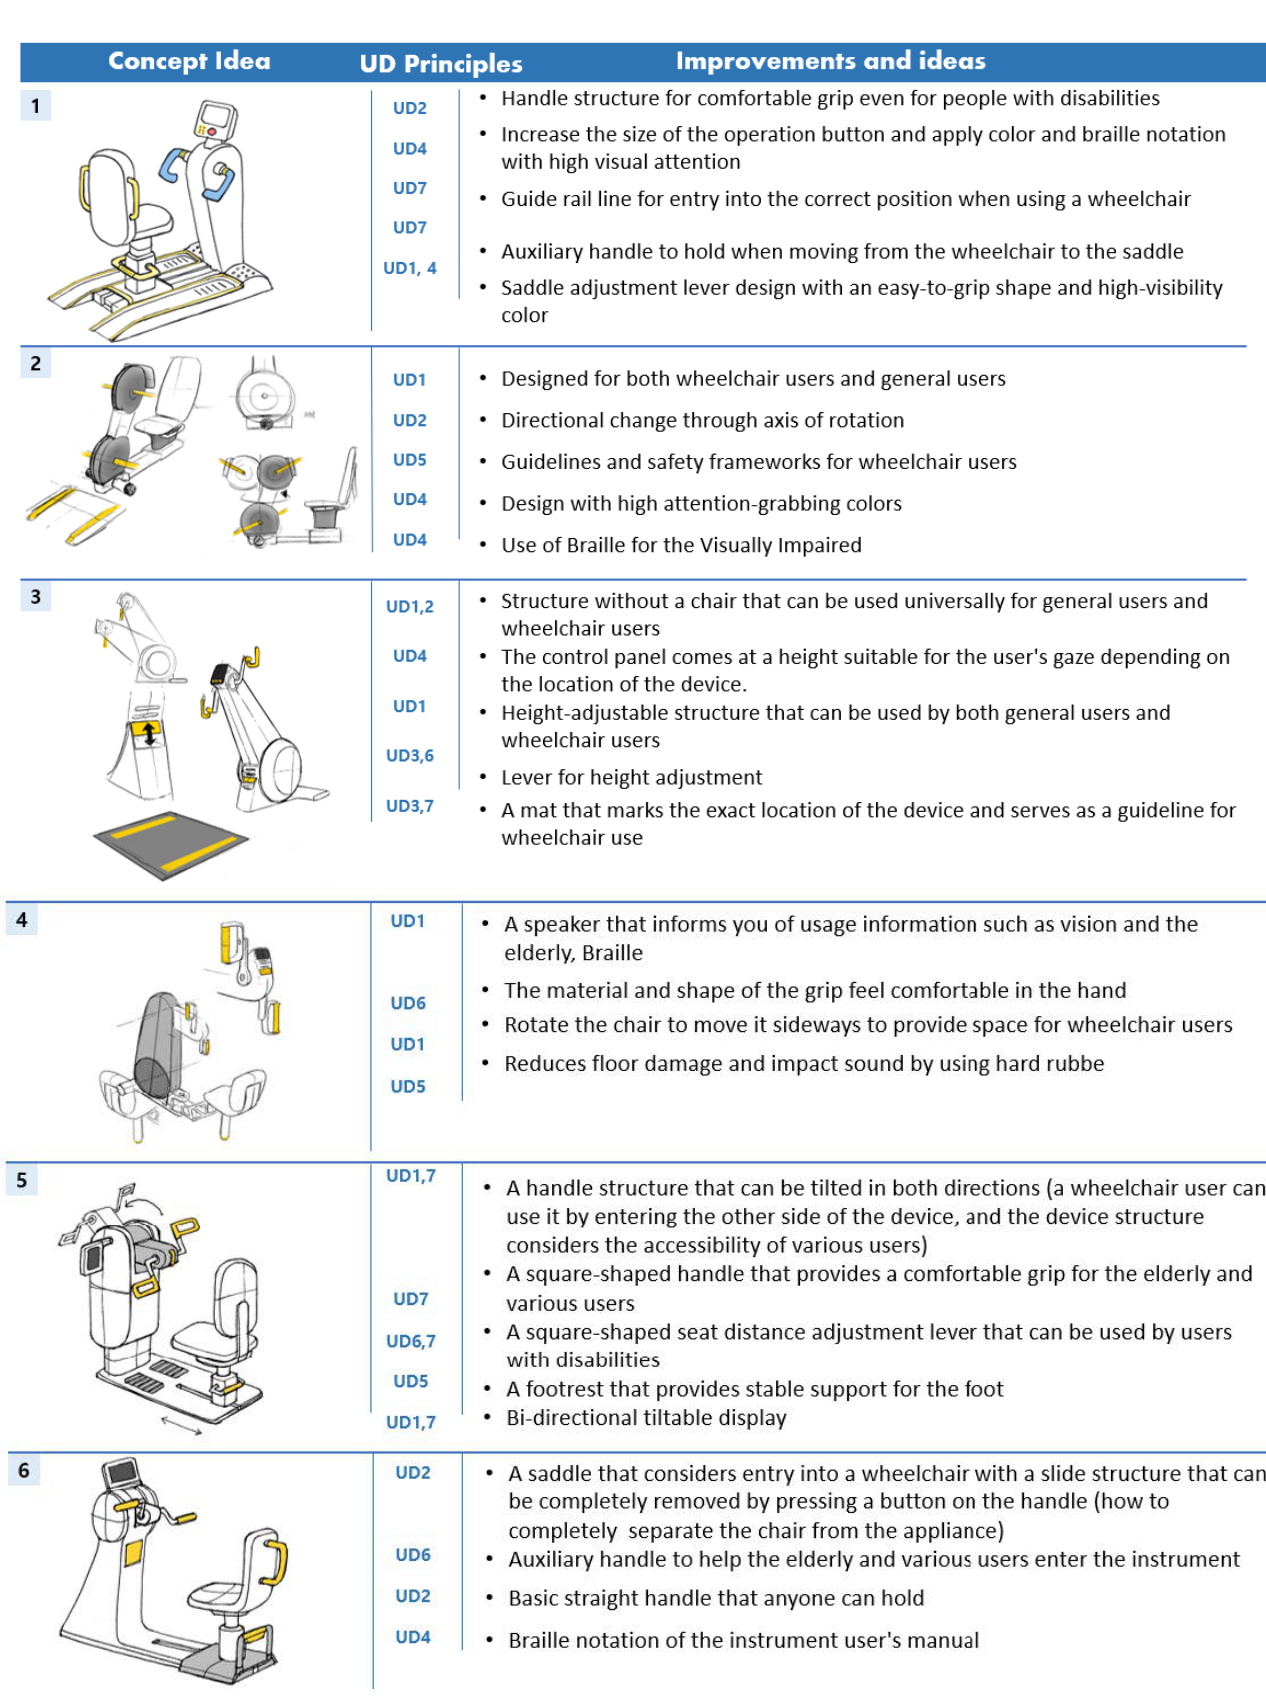
Figure 6. Six types of concept ideas for an arm ergometer based on UD .